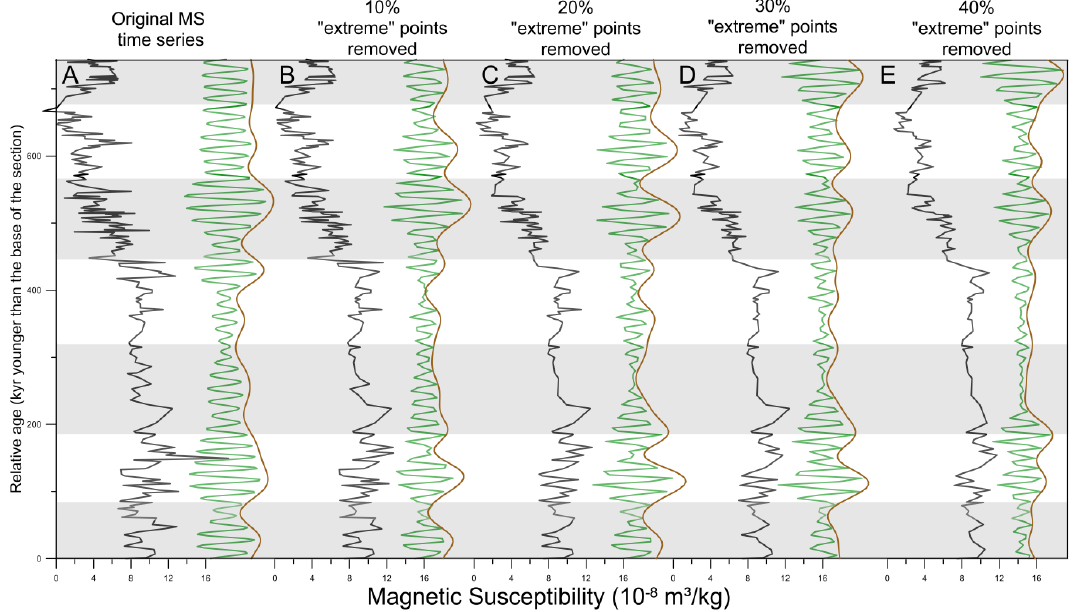
Fig. 8. Robustness-test of the amplitude modulation of the precessional signal in the MS time-series. (A) : origninal MS time-series (black), its precessional signal (green) and the amplitude envelope of the precessional singal (brown). (B, C, D, E) : MS time-series of which the 10%–20%–30%–40% most extreme MS values are removed (black) and its precessional signal (green).